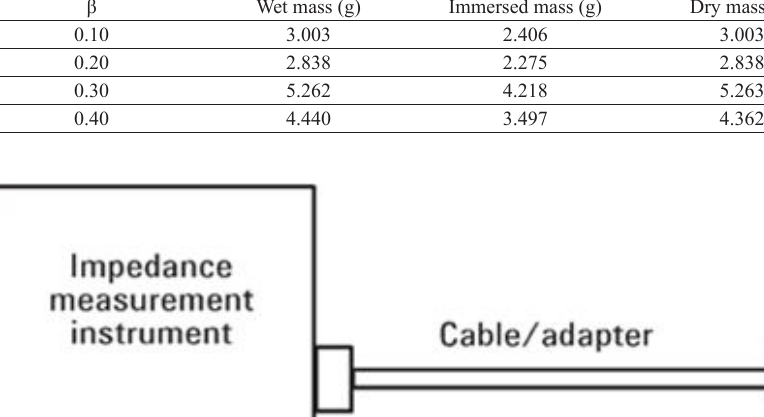
Table 5. Results of the mass measurements of the pellet samples in wet, immersed, and dry conditions. β Wet mass (g) Immersed mass